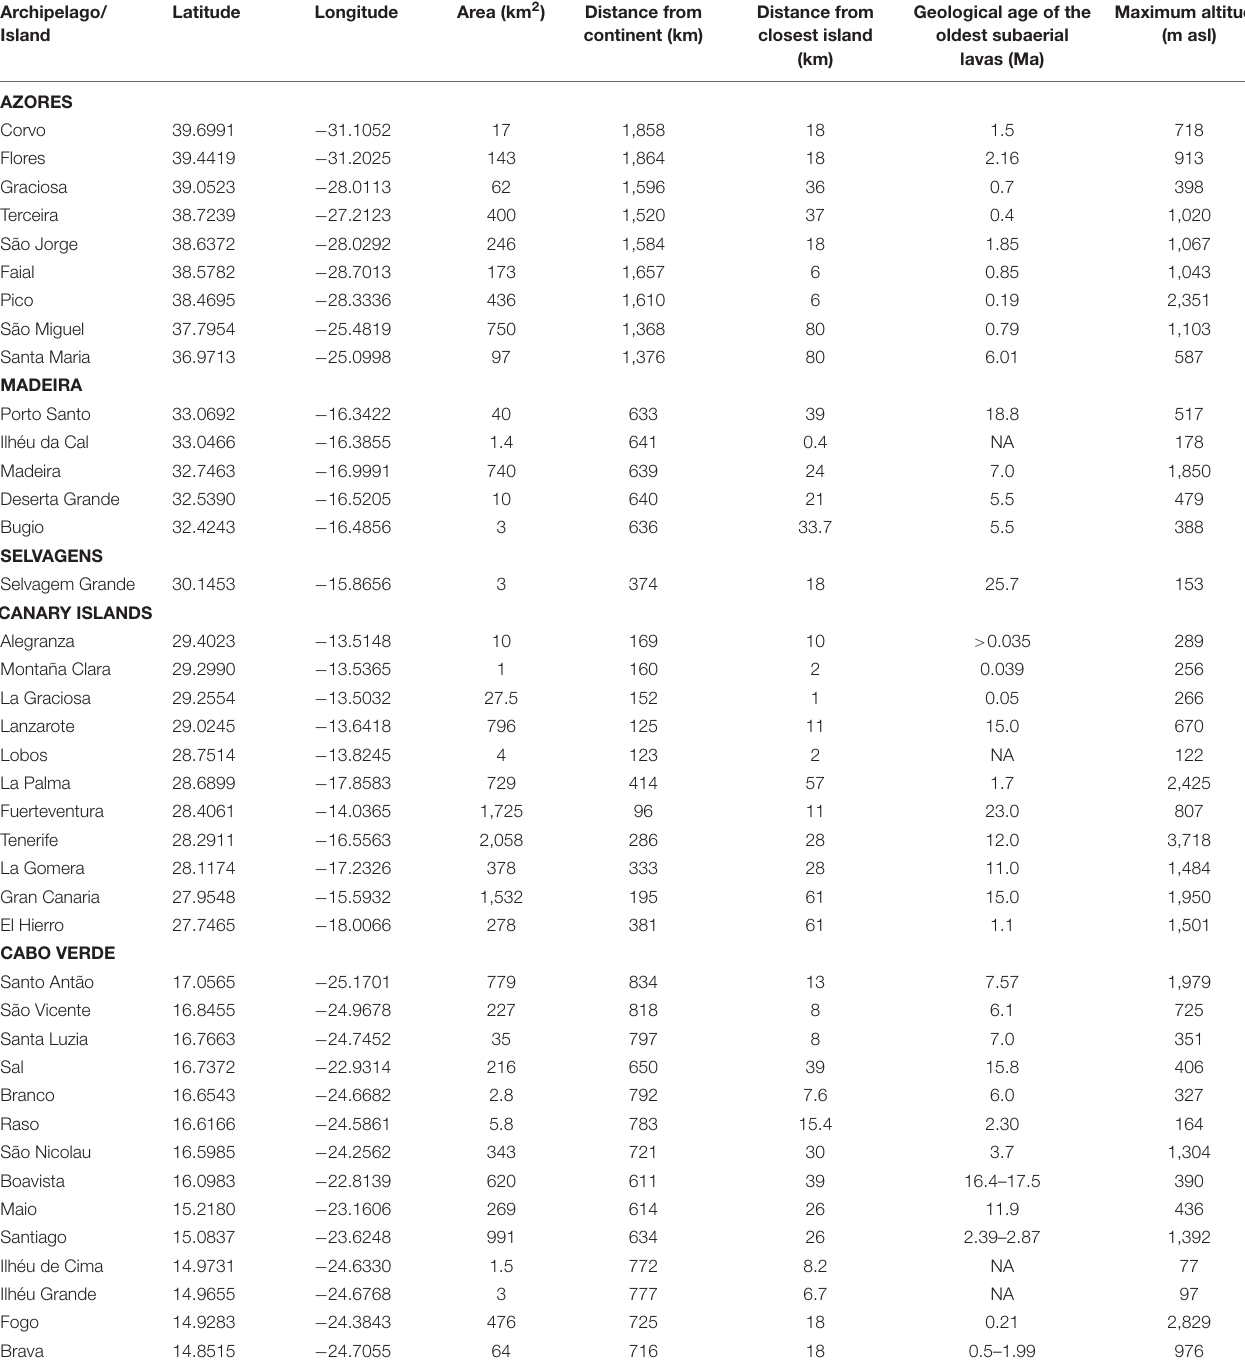
TABLE 1 | Main characteristics of the islands and islets larger than 1 km 2 included in the Macaronesian archipelagos of the Azores, Madeira, Selvagens, Canary Islands, and Cabo Verde (compiled from Geldmacher et al., 2001; Torres et al., 2002; Madeira et al., 2005; Azevedo and Portugal Ferreira, 2006; Holm et al., 2006; Ancochea et al., 2010; Dyhr and Holm, 2010; Madeira et al., 2010; Ramalho, 2011; Ancochea et al., 2012; van den Bogaard, 2013; Aranda et al., 2014; Johnson et al., 2014; Ancochea et al., 2015; Costa et al., 2015; Ramalho et al., 2015; Ávila et al., 2016 and references therein; Ramalho et al., 2017; Samrock et al., 2018; Marques et